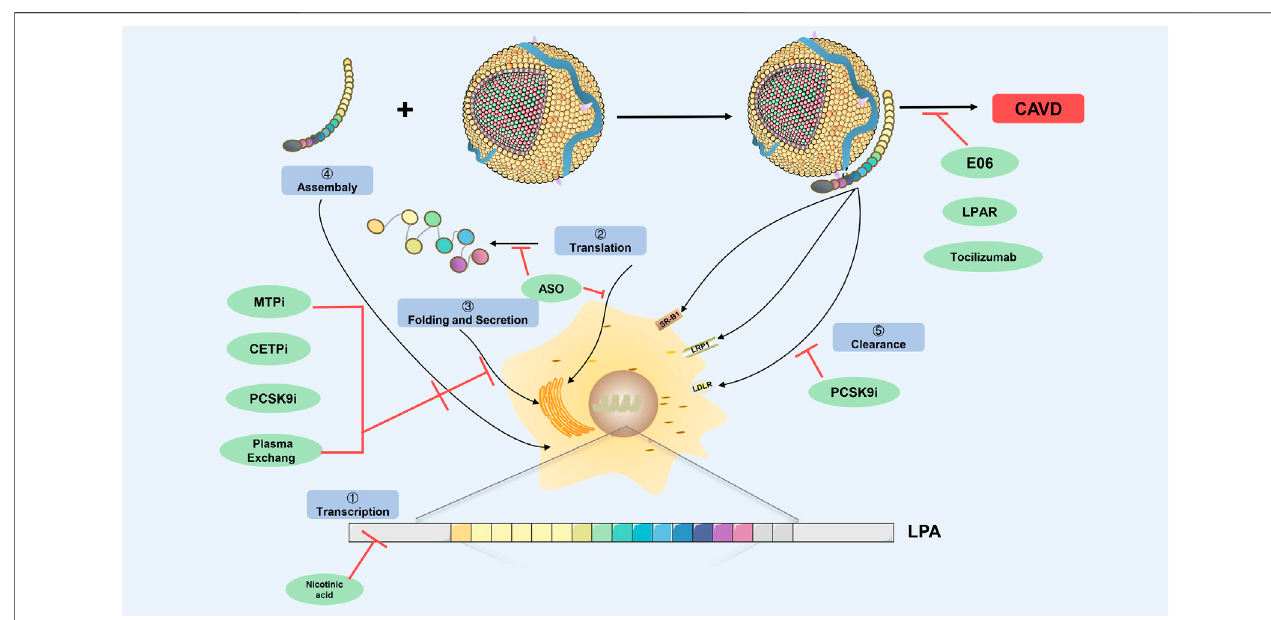
FIGURE3| ProspectingtreatmentofLp(a)-mediatedCAVD.SchematicdiagramdepictsregulationpointsforLp(a)biosynthesisandcatabolism(highlightedinblue boxes) as a prospecting treatment target. The green ovals indicate therapeutic agents that have been shown to modulate Lp(a) levels, and potentially Lp(a) pathogenic affects. The prospecting treatment target at which they act is shown with red lines. CETPi, CETP inhibitor; PCSK9i, PCSK9 inhibitor; ASO, antisense oligonucleotides; MTPi, microsome triglyceride transfer protein inhibitor; LRP-1, low-density lipoprotein receptor-related protein-1; SR-B1, scavenger receptor B1; LDLR, low-density lipoprotein receptor; CAVD, calci fi c aortic valve disease.